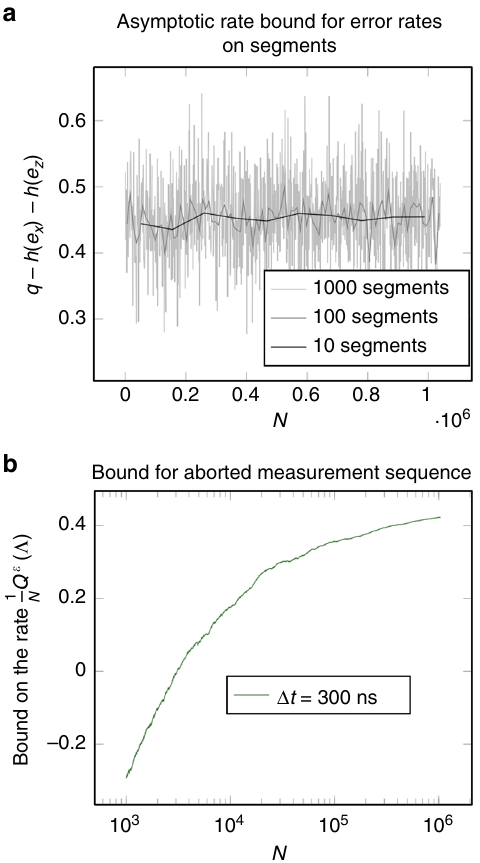
Fig. 4 Error fl uctuations across the measurements. Here we visualize the statistical fl uctuations in the measurement outcomes over the course of the transmon qubit experiment. a For the experiment with Δ t = 300 ns, we split up the N = 1.04 × 10 6 sequential measurement outcomes into equally large and chronologically ordered segments and calculate the error rates e x and e z on each segment. For a meaningful and comparable quantity for comparison, we calculate the asymptotic bound q (cid:5) h e x ð Þ (cid:5) h e z ð Þ for each of segment with q = 0.9, that is, the bound on the capacity rate that would be obtained if in fi nitely many measurements with the error rates as on the respective segments would be measured. As expected, the fl uctuations decrease with the number of segments, or in other words, the larger the segments, the smaller the differences between them. Note that in contrast to all other plots, this is a linear plot. b For a glimpse on the cumulative effect of the fl uctuations, we set 1000 logarithmically distributed “ break points ” and calculate the bound as if the experiment ended at each of those points where q = 0.9, ε = 10 − 6 , and we pick p = 1/2. The resulting plot is to be compared with the plots in Fig. 5. The fl uctuations that make the curve deviate from a smooth curve come from the fact that the measured error rates are not constant throughout the experiment, indicating that the noise affecting the transmon qubit is indeed unlikely to correspond to an i.i.d. process